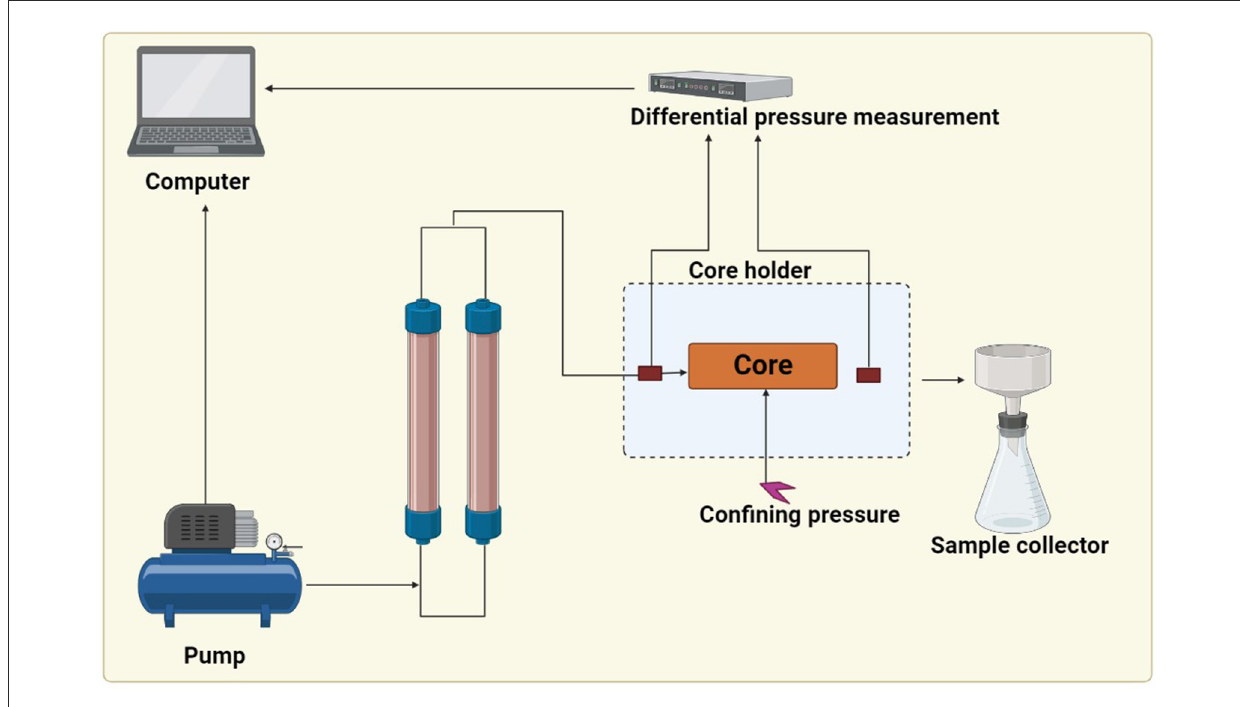
FIGURE2 Schematic of core flood apparatus.